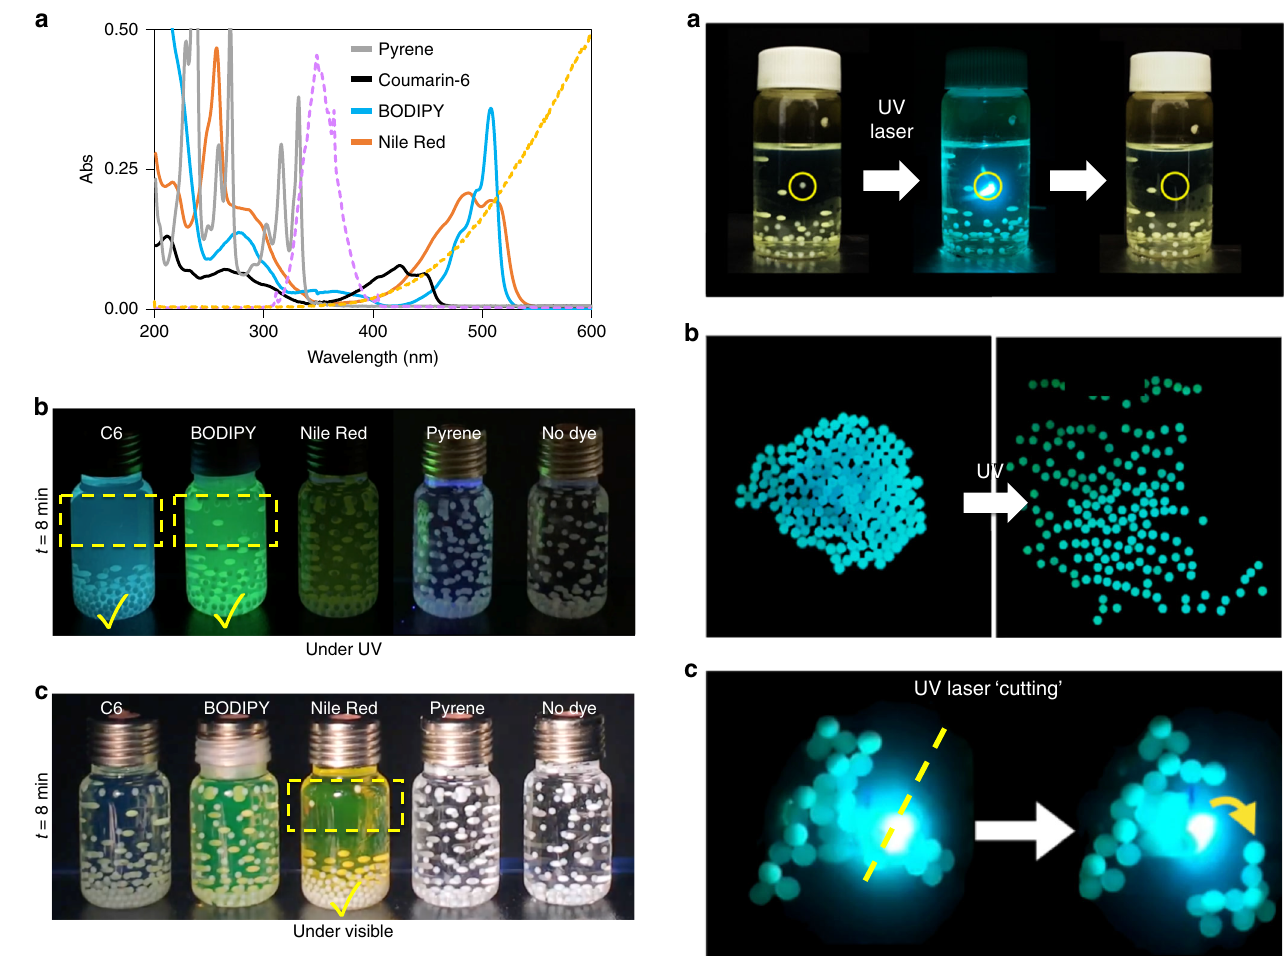
Fig. 4 Wavelength control in discharging of tribocharges on polymers by light. a The emission spectra of the dyes; pyrene, Coumarin 6 (C6), (4,4- Di fl uoro-1,3,5,7-Tetramethyl-4-Bora-3a,4a-Diaza-s-Indacene) BODIPY, and Nile Red (all in hexane) used as mediators and the emission pro fi les of the light sources used in discharging ultraviolet (UV) lamp, purple dashed line (centered at ca. 350 nm) and tungsten lamp, yellow dashed line). For comparison, dye concentrations were adjusted as 1 × 10 − 5 M, 1 × 10 − 5 M, 5 × 10 − 4 M, and 1 × 10 − 5 M, respectively. b Forty Poly(tetra fl uoroethylene) (PTFE) beads tribocharged in the dye solutions (all 1 × 10 − 5 M, hexane) in glass vials illuminated on the UV lamp with the emission pro fi le shown in a . See also Supplementary Movie 3. c Same vials are illuminated only with visible light (tungsten lamp, pro fi le shown in a ). See also Supplementary Movie 4. A wavelength match between the absorption band of the dye and the emission pro fi le of the light source is necessary for a successful discharge — however, it is not suf fi cient for some dyes, e.g., pyrene, After the shaking time is over, the beads that are stuck on the walls of the vial through electrostatic adhesion were monitored by a video camera and their indi- vidual retention times on the glass vial (discharging times) were noted. Each downward motion (slipping, hopping, or falling to the bottom of the vial) of the tribocharged beads is termed as “ 1 discharge event ” . For analysis, data from fi ve or six independent experiments was collected (a total of 200 – 240 beads for each experiments, from which only the beads displaying the above-mentioned “ dis- charged events ” were counted); curve fi t on data was made by Matlab 2017 pro- gram using distribution function. An example of the collected data and the curve fi t can be seen in Supplementary Figure 12. The experiments were then repeated for different shaking times, in presence of the dye solutions or pure solvents to obtain discharging time pro fi les.